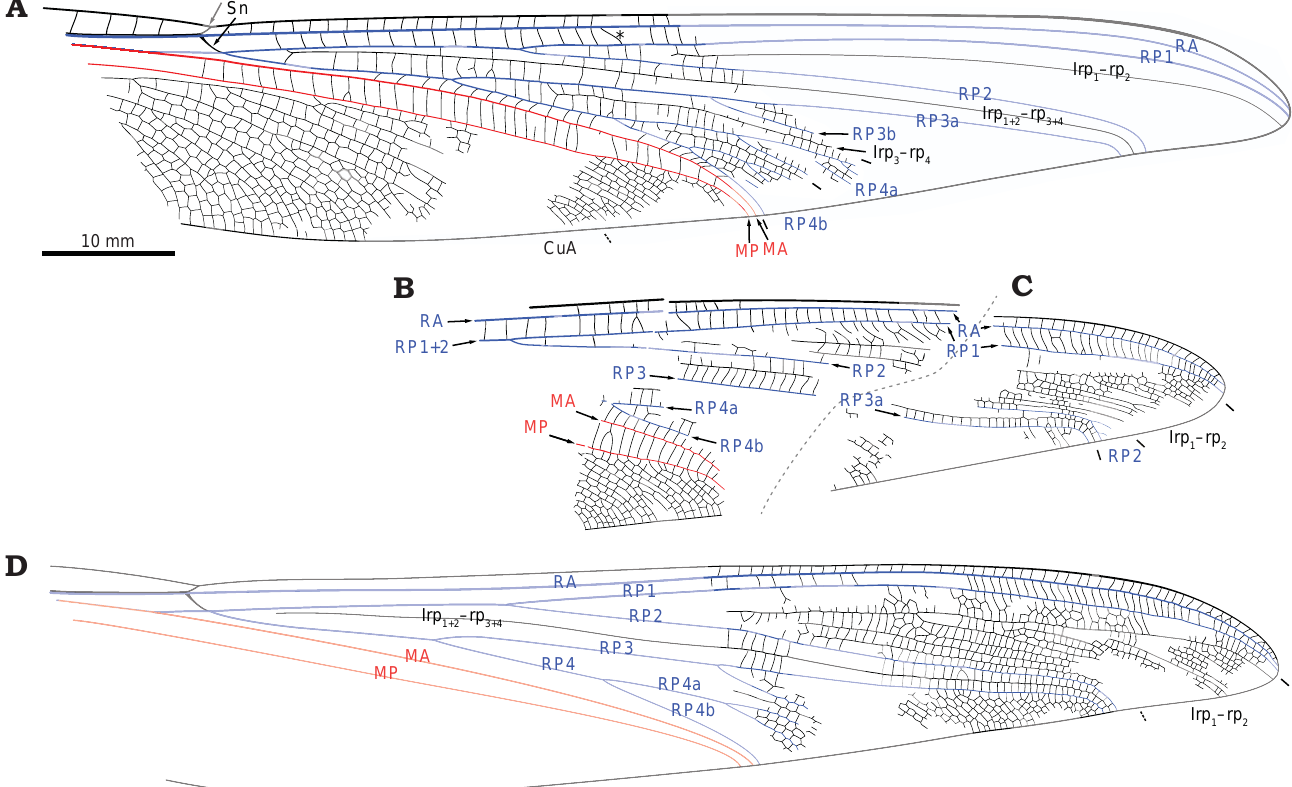
Fig. 1. Triadotypid insect Reisia rieki sp. nov. from Carnian (Triassic) of Kapokkraal (A, B, D) and Aasvoëlberg (C) localities, Molteno Formation, Karoo Basin, South Africa. A . PRE/F/17569, right wing. B . PRE/F/16442, left wing. C . PRE/F/10616, right wing. D . PRE/F/17499, right